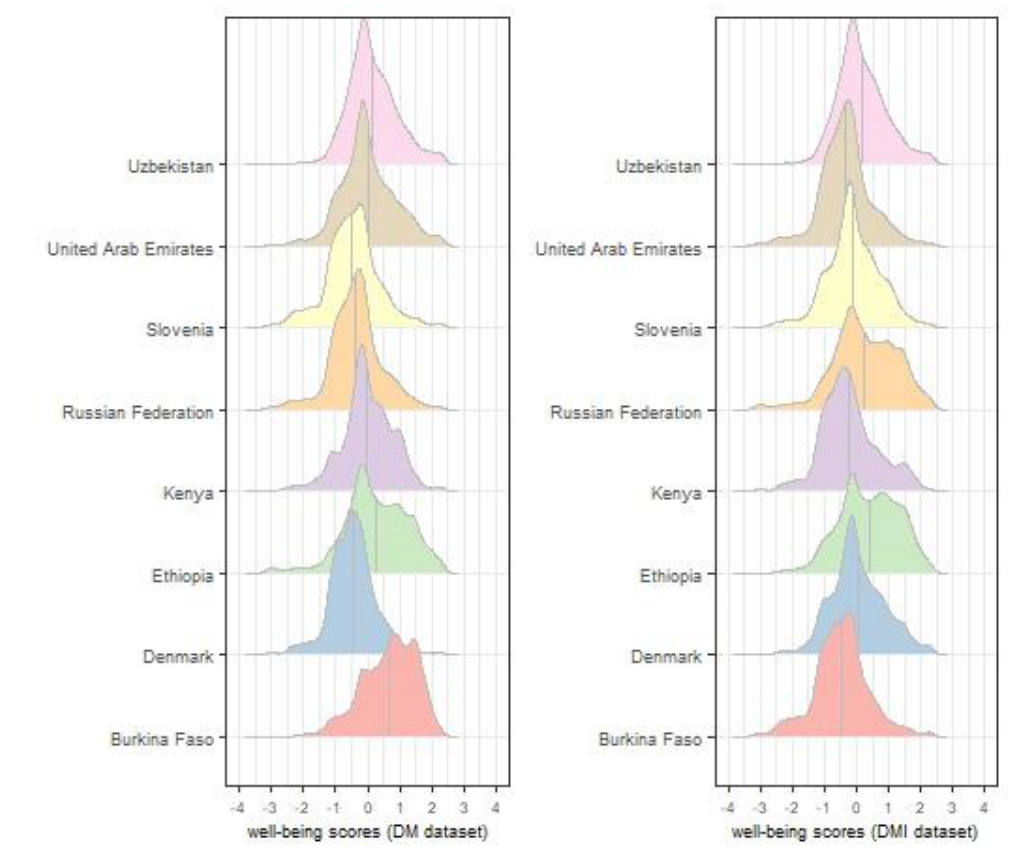
Figure 1. Distribution of well-being scores using DM and DMI datasets.